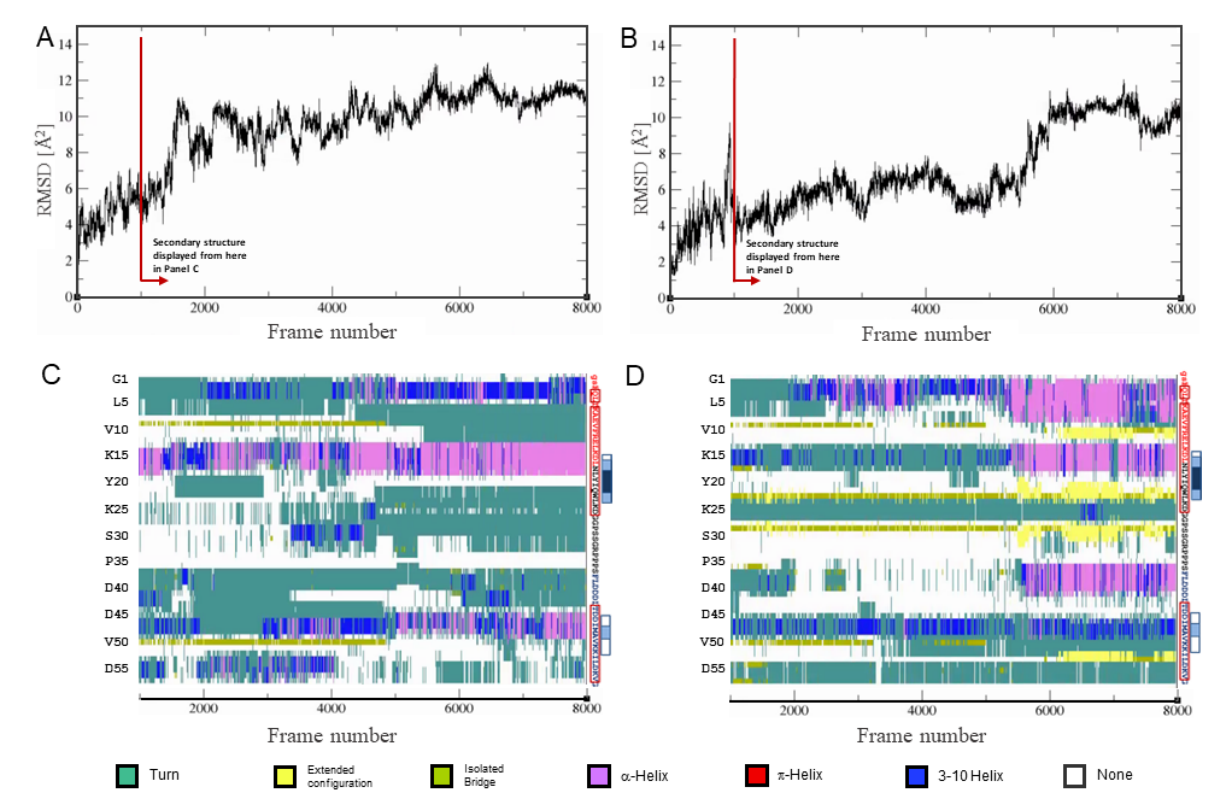
Figure 8. MD simulation of A-Cage-C in water and the presence of DOPC and DOPC:DOPS bilayers. ( A ) Simulation of A-Cage-C in water and the presence of DOPC bilayers. The C α RMSD values are calculated relative to the starting structure, selected as described in the Materials and Methods section. Each frame of simulation represents 100 ps, and the total simulation time was 800 ns. The red arrow indicates from which frame secondary structure is presented in the panel below. ( B ) Simulation of A-Cage-C in water and in the presence of DOPC:DOPS (4:1) bilayers. The C α RMSD values are calculated relative to the starting structure, selected as described in the Materials and Methods section. Each frame of simulation represents a 100 ps, and the total simulation time was 800 ns. The red arrow indicates from which frame secondary structure is presented in the panel below. ( C ) A-Cage-C simulated in the presence of DOPC bilayers, where A-Cage-C secondary structure determined by DSSP as a function of simulation time and residue position. ( D ) A-Cage-C simulated in the presence of DOPC bilayers, where A-Cage-C secondary structure determined by DSSP as a function of simulation time and residue position. For the two bottom panels, sequence information aligned with the vertical axis can be found to the right at each panel. Red, black, and blue capital letters indicate Helix A, Trp-Cage, and Helix C motifs; lower case letters indicate two remaining residues from TEV cleavage; Red frames indicate predicted helices; White, light blue and dark blue boxes indicate increasing AMYLPRED2 consensus. For further details, see Figure 2 and Materials and